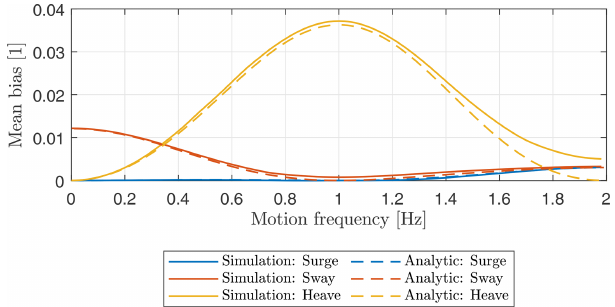
Figure 10. Mean bias as function of frequency of motion for trans- lational degrees of freedom. Solid lines are results from the FLS simulator, and dashed lines are the analytical solution presented in Sect. A5. κ = 0 . 22, as in Fig.